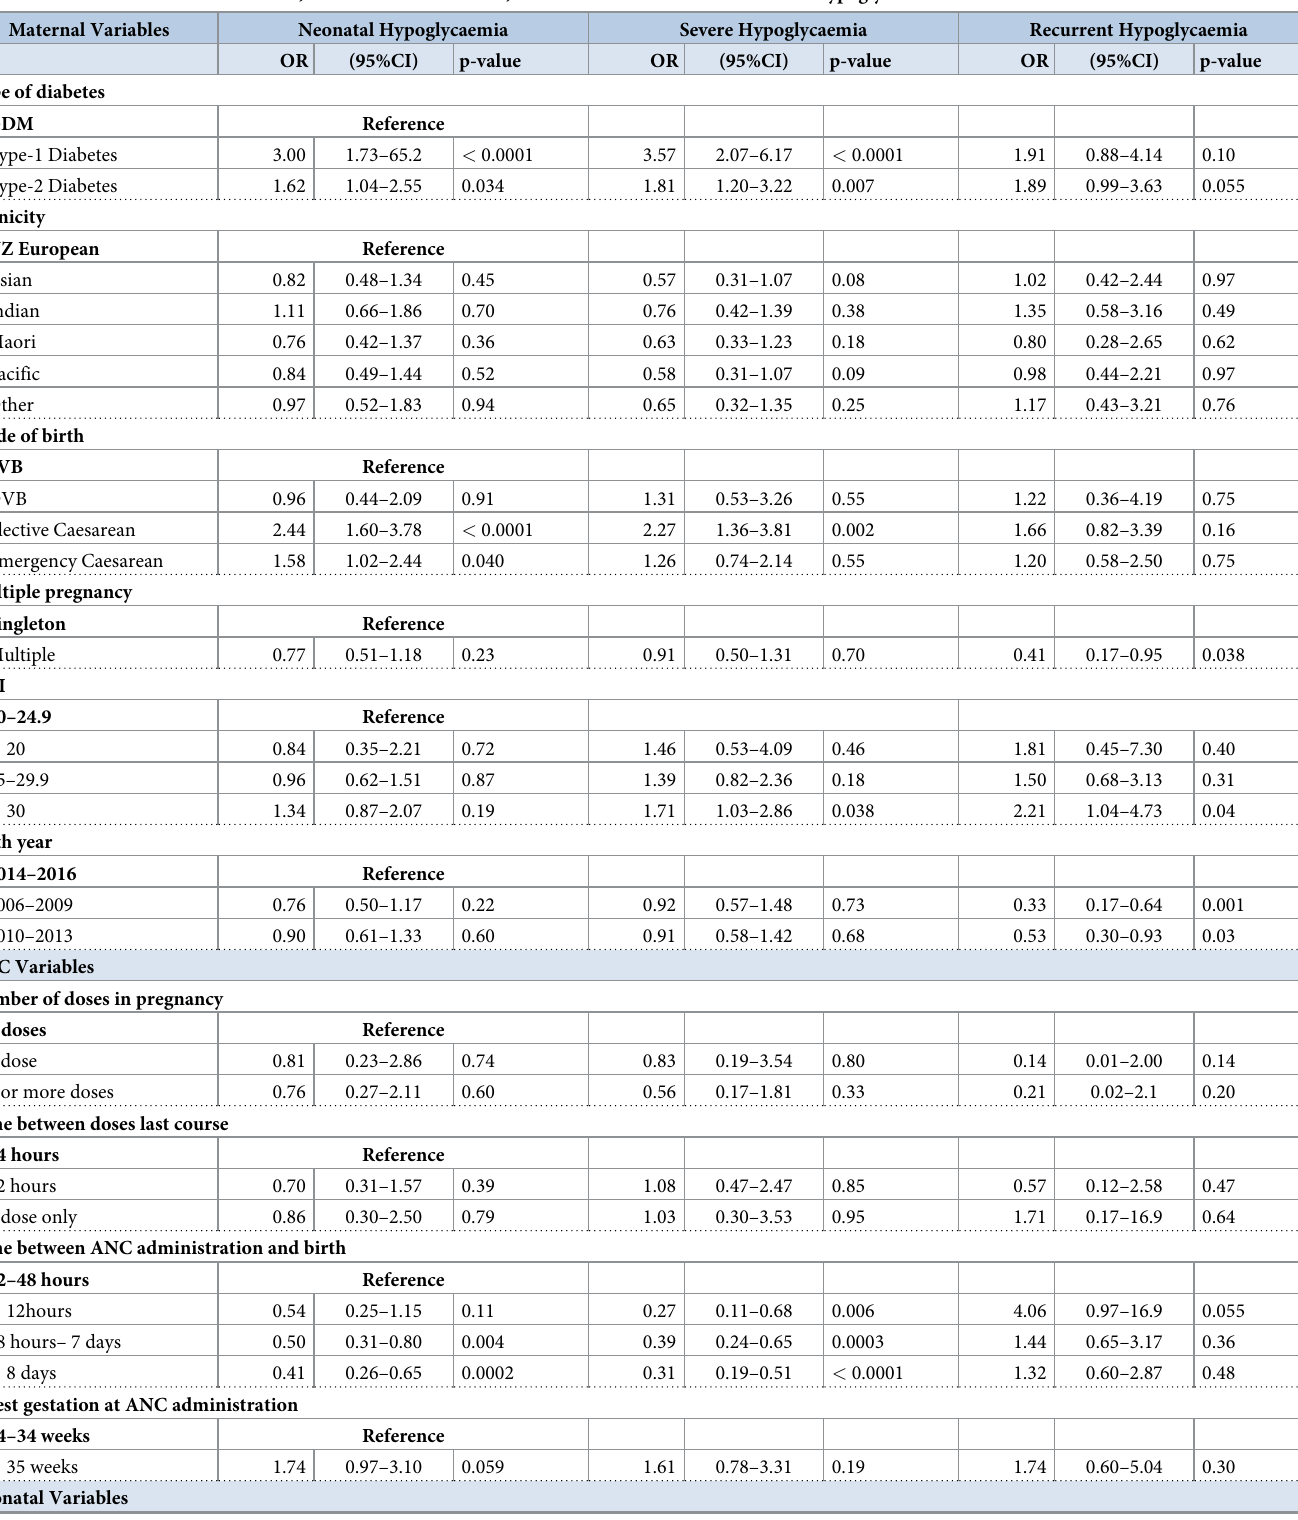
Table 3. Associations between maternal, antenatal corticosteroid, and neonatal variables and neonatal